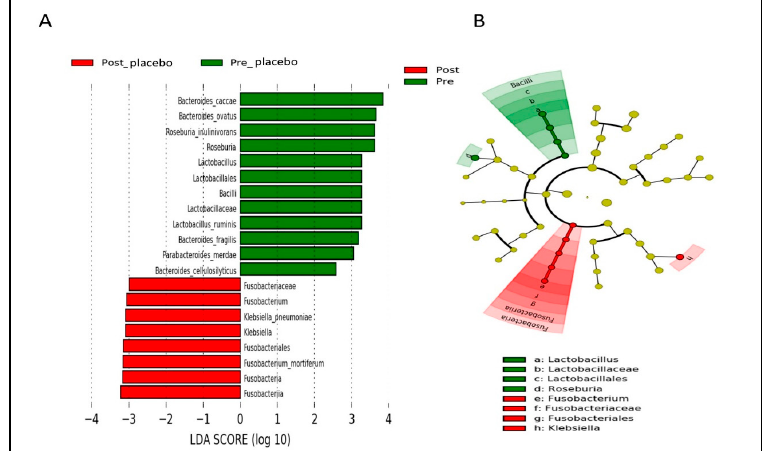
Figure 9. Linear discriminant analysis (LDA) effect size (LEfSe) analysis showing significantly abun- dant gut microbial taxa down to species level within the placebo group. ( A ) Histogram represents the LDA scores for differentially abundant gut microbial taxa within the placebo group, pre- and post-intervention. ( B ) Cladogram represents the taxonomic structure and relative abundance of the predominant gut microbial taxa within the placebo group, pre- and post-intervention. The size of each dot in the cladogram represents the relative abundance of the identified gut microbial taxa. α < 0.05 and LDA score ≥ 2.0 were considered statistically significant.